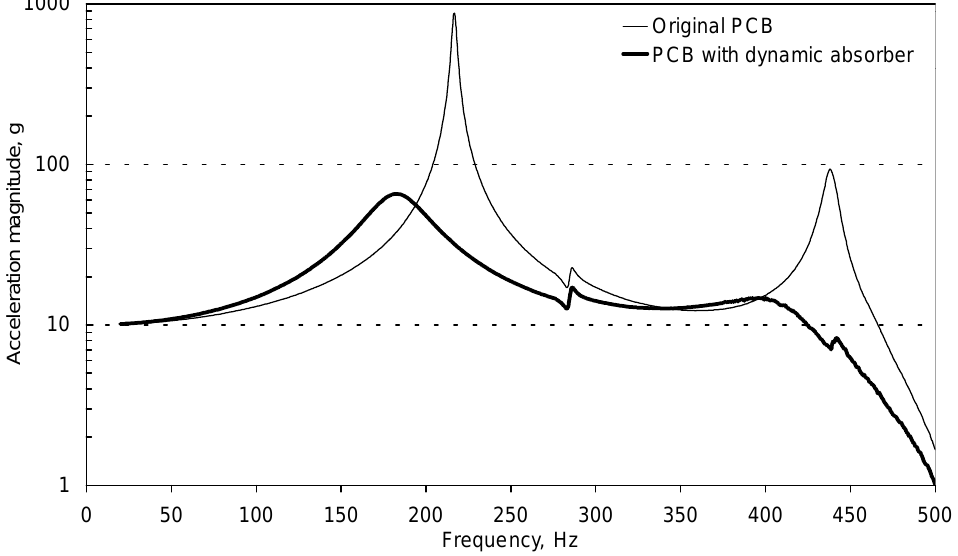
Fig. 11. Performance of dynamic absorber under swept sine